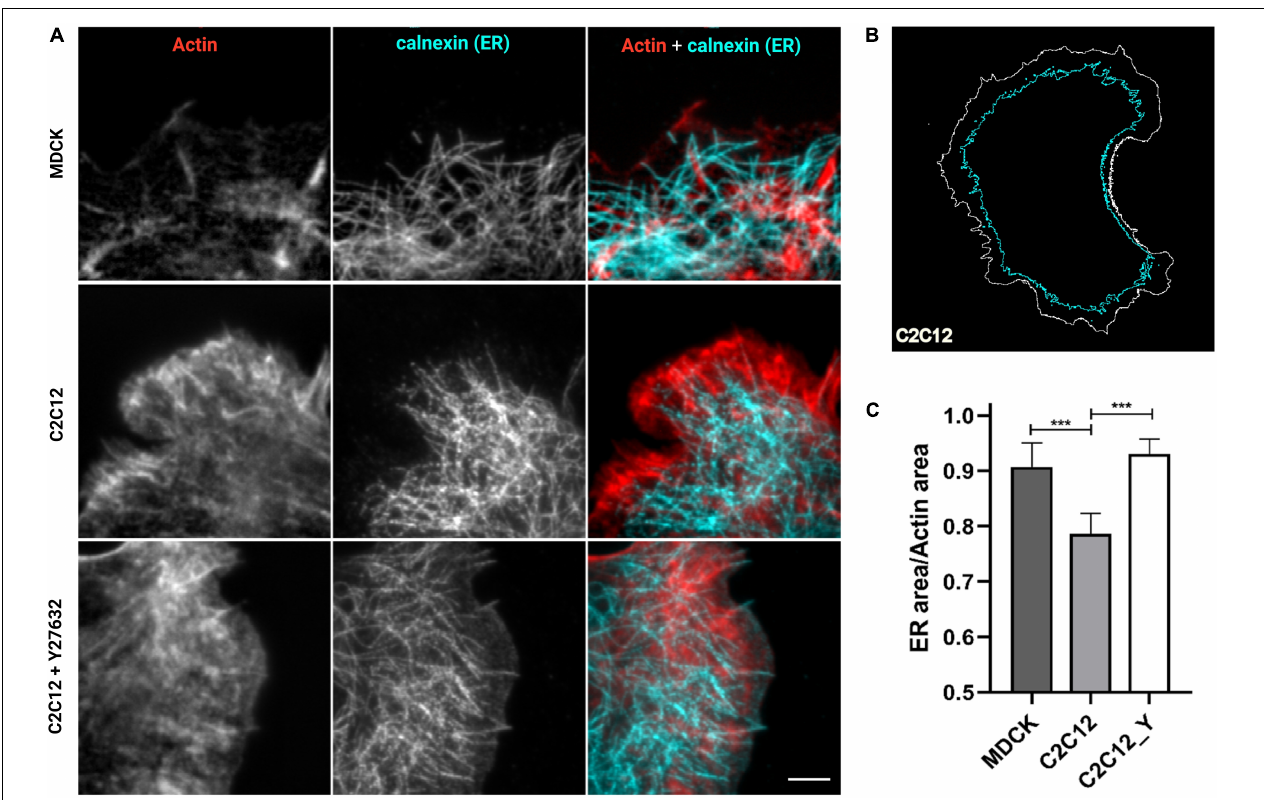
FIGURE 3 | ER is directed toward cell–cell contacts in MDCK cells but are maintained at a distance in C2C12 cells. Release of tension by Y-27632 allows the ER to reach the adhesion similar to MDCK cells. (A) Cells transfected for calnexin-mEmerald (for ER identification, in cyan in the images) were plated on cad-Fc biomimetic substrates, left untreated (MDCK and C2C12) or treated with Y compound (Y27632, 10 µ M for 1 h), and marked for actin (red) and ER (cyan). Only a small amount of ER (cyan) penetrated the cadherin-mediated adhesion areas of C2C12 cells spread on Ncad-Fc, whereas ER occupies the whole periphery of MDCK cells spread on Ncad-Fc. Images were acquired with a 60x objective, 1.49NA Plan-Apo (Nikon). Scale bar, 5 µ m. (B) Exemplary contour of the total cell area versus the area occupied by ER. (C) The fraction of the whole cell surface occupied by the ER network in MDCK cells, C2C12 cells, and C2C12 treated with Y-27632. The data show the mean ± SD. ( n = 8 cells analyzed per condition). *** P < 0.0001 (unpaired Student’s t